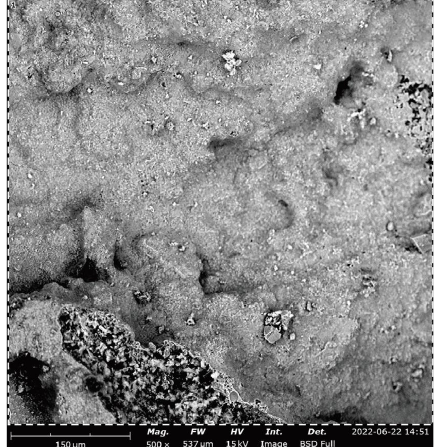
Figure 33: SEM for M3